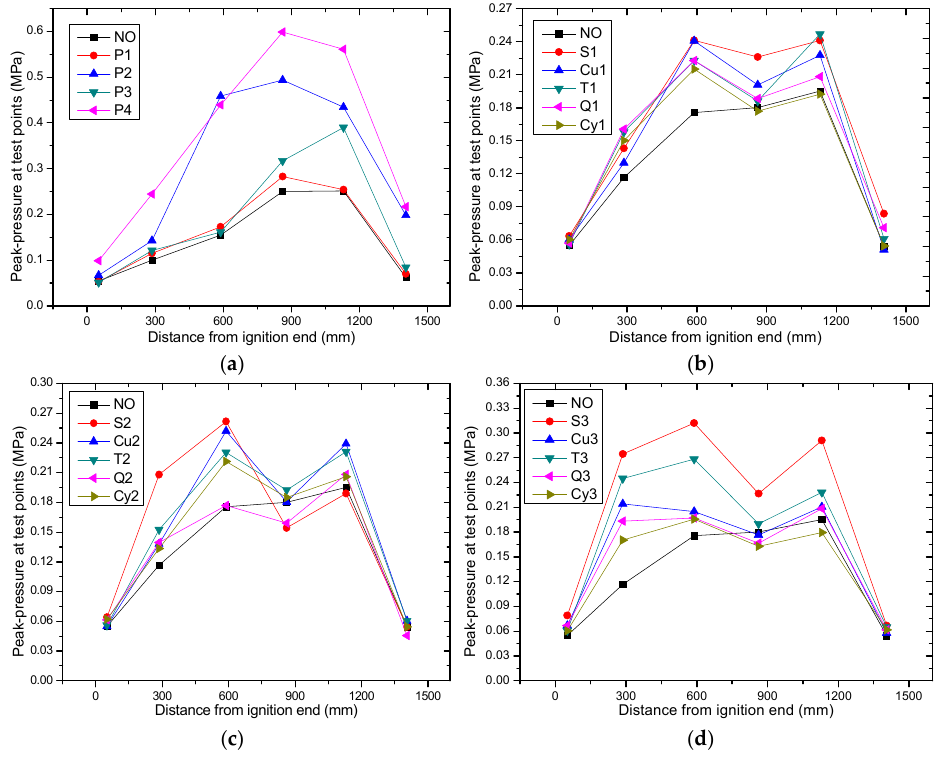
Figure 7. Flame pressure distribution for placed repeated baffles in tube, 9.47 vol % CH 4 ; ( a ) flame pressure distribution for placed different types of solid structure obstacles in tube, 10.50 vol % CH 4 , ( b ) BR = 20%; ( c ) BR = 40%; and ( d ) BR = 60%.